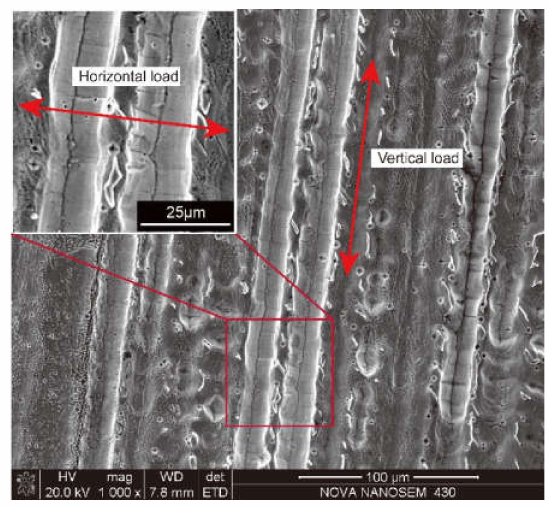
Figure 14. SEM photos of morphology of cross section in the middle region of sample